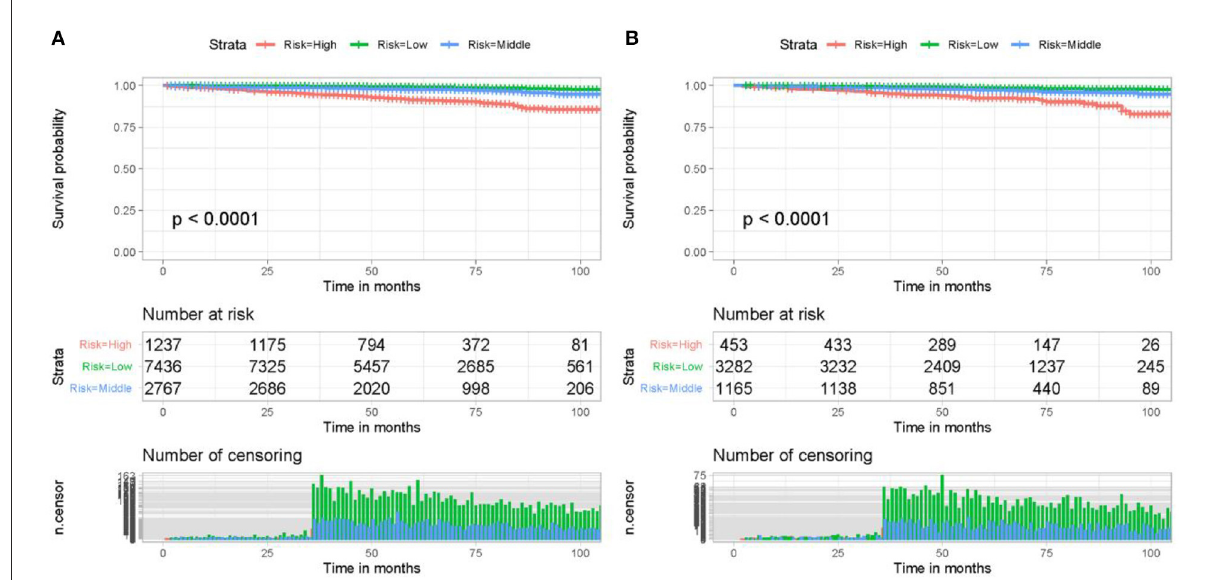
FIGURE7 The risk classification system could effectively classify older female primary breast cancer patients that underwent chemotherapy in the training cohort (A) and validation cohort (B) into three risk subgroups with significant differences. Kaplan-Meier survival curves demonstrated that older female primary breast cancer patients that underwent chemotherapy in the high-risk subgroup had a worse prognosis than those in the low-risk